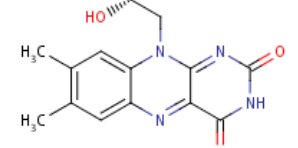
Figure 10. Riboflavin structure.